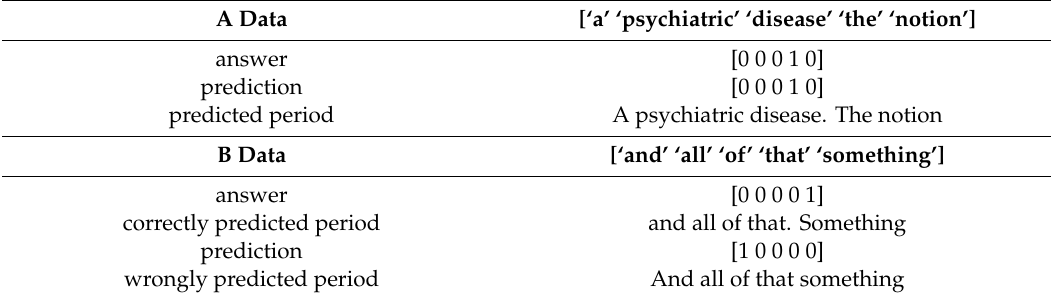
Table 6. Examples of correct prediction and wrong